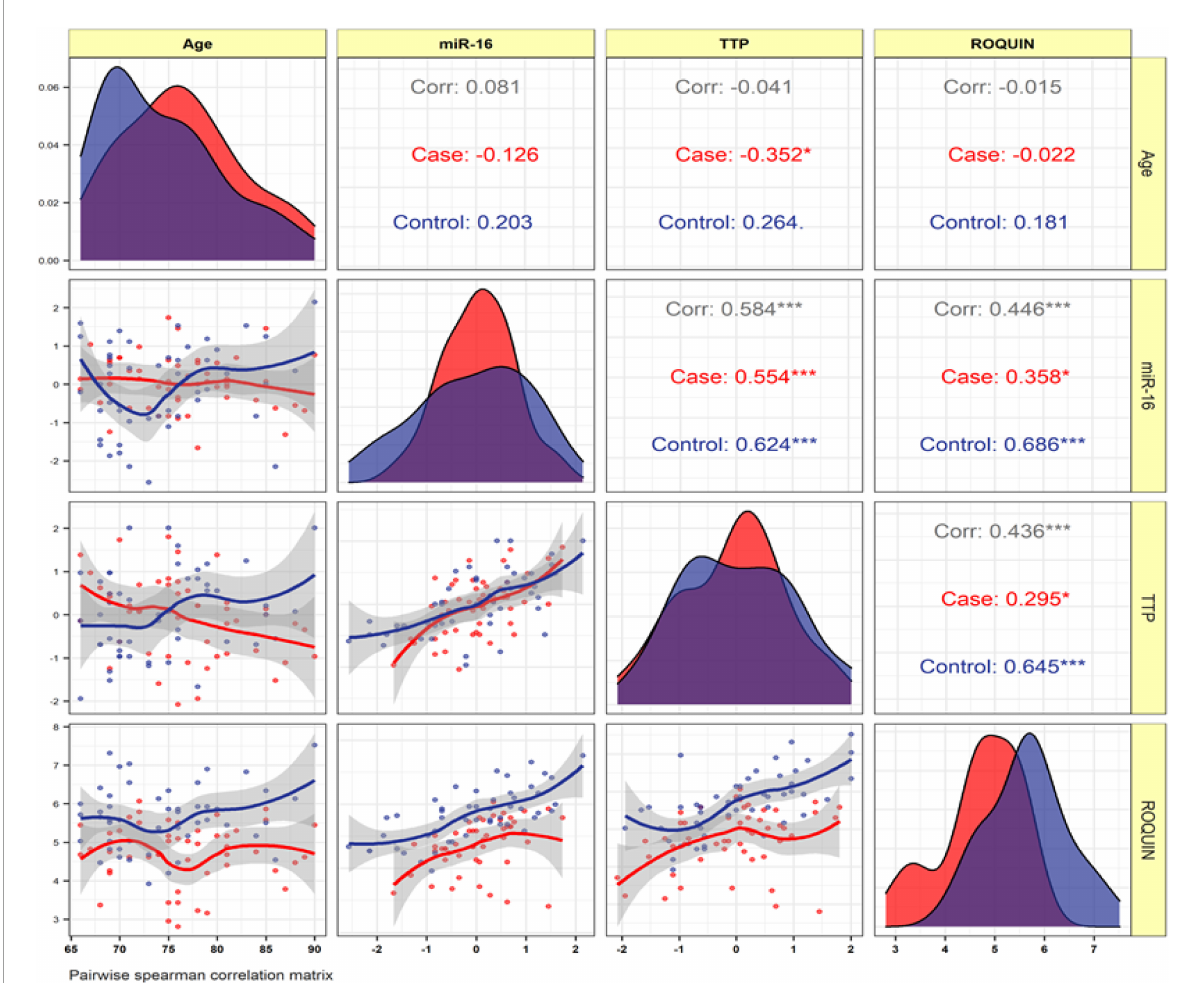
FIGURE6 The variable distribution is displayed on the diagonal. The correlation coefficients, as well as the significance level, are shown as stars. * and ***represent a significant correlation at p < 0.05 and P < 0.001,